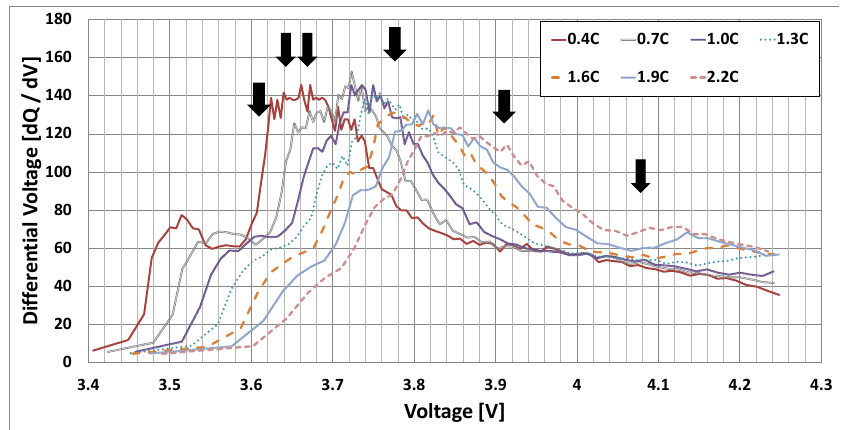
Figure 4. The differential voltage analysis plot of the ICR18650-33F 3.3 Ah cell employed herein.